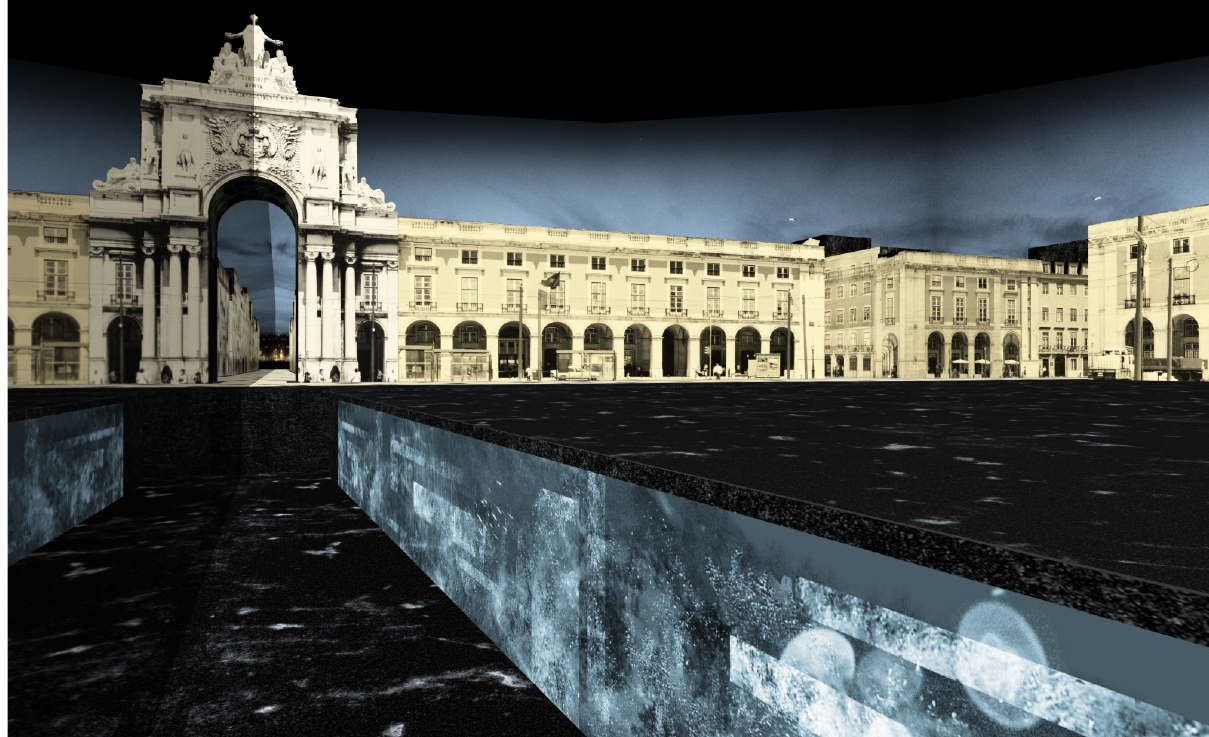
Fig. 8 Lisbon model: Praça do Comerçio and the acquarium The prevalence of pictures and textures over geometries derives from the premises declared at first. In the model, as in a painted scenery, solid structure acts as a simple support for the images. mapped environment made of photos rather than artificial